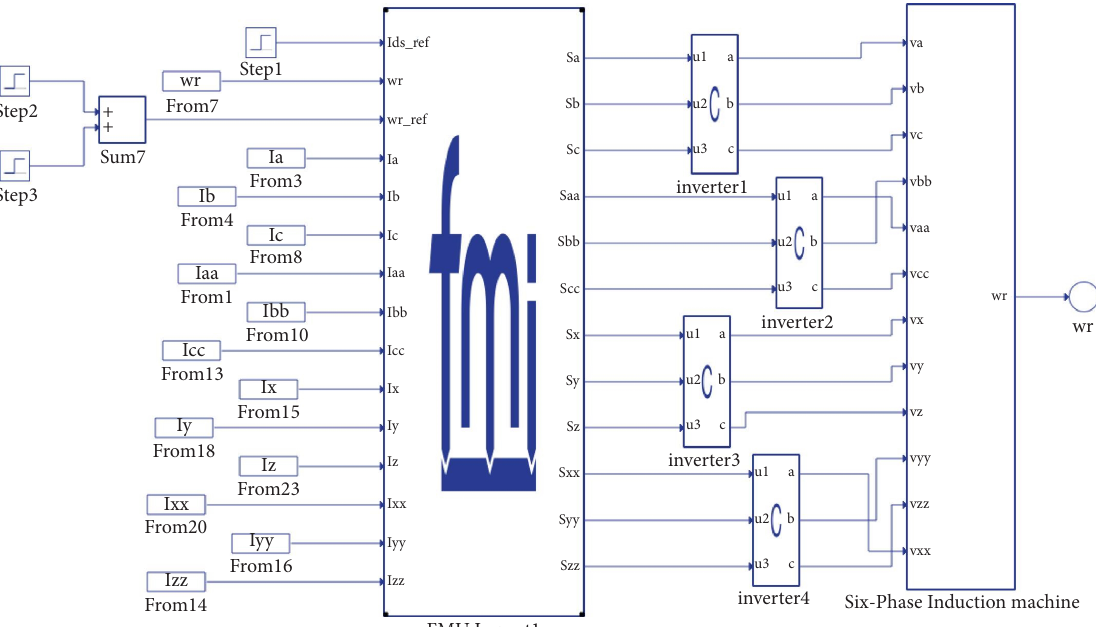
Figure 11: HIL testing model of the drive system.